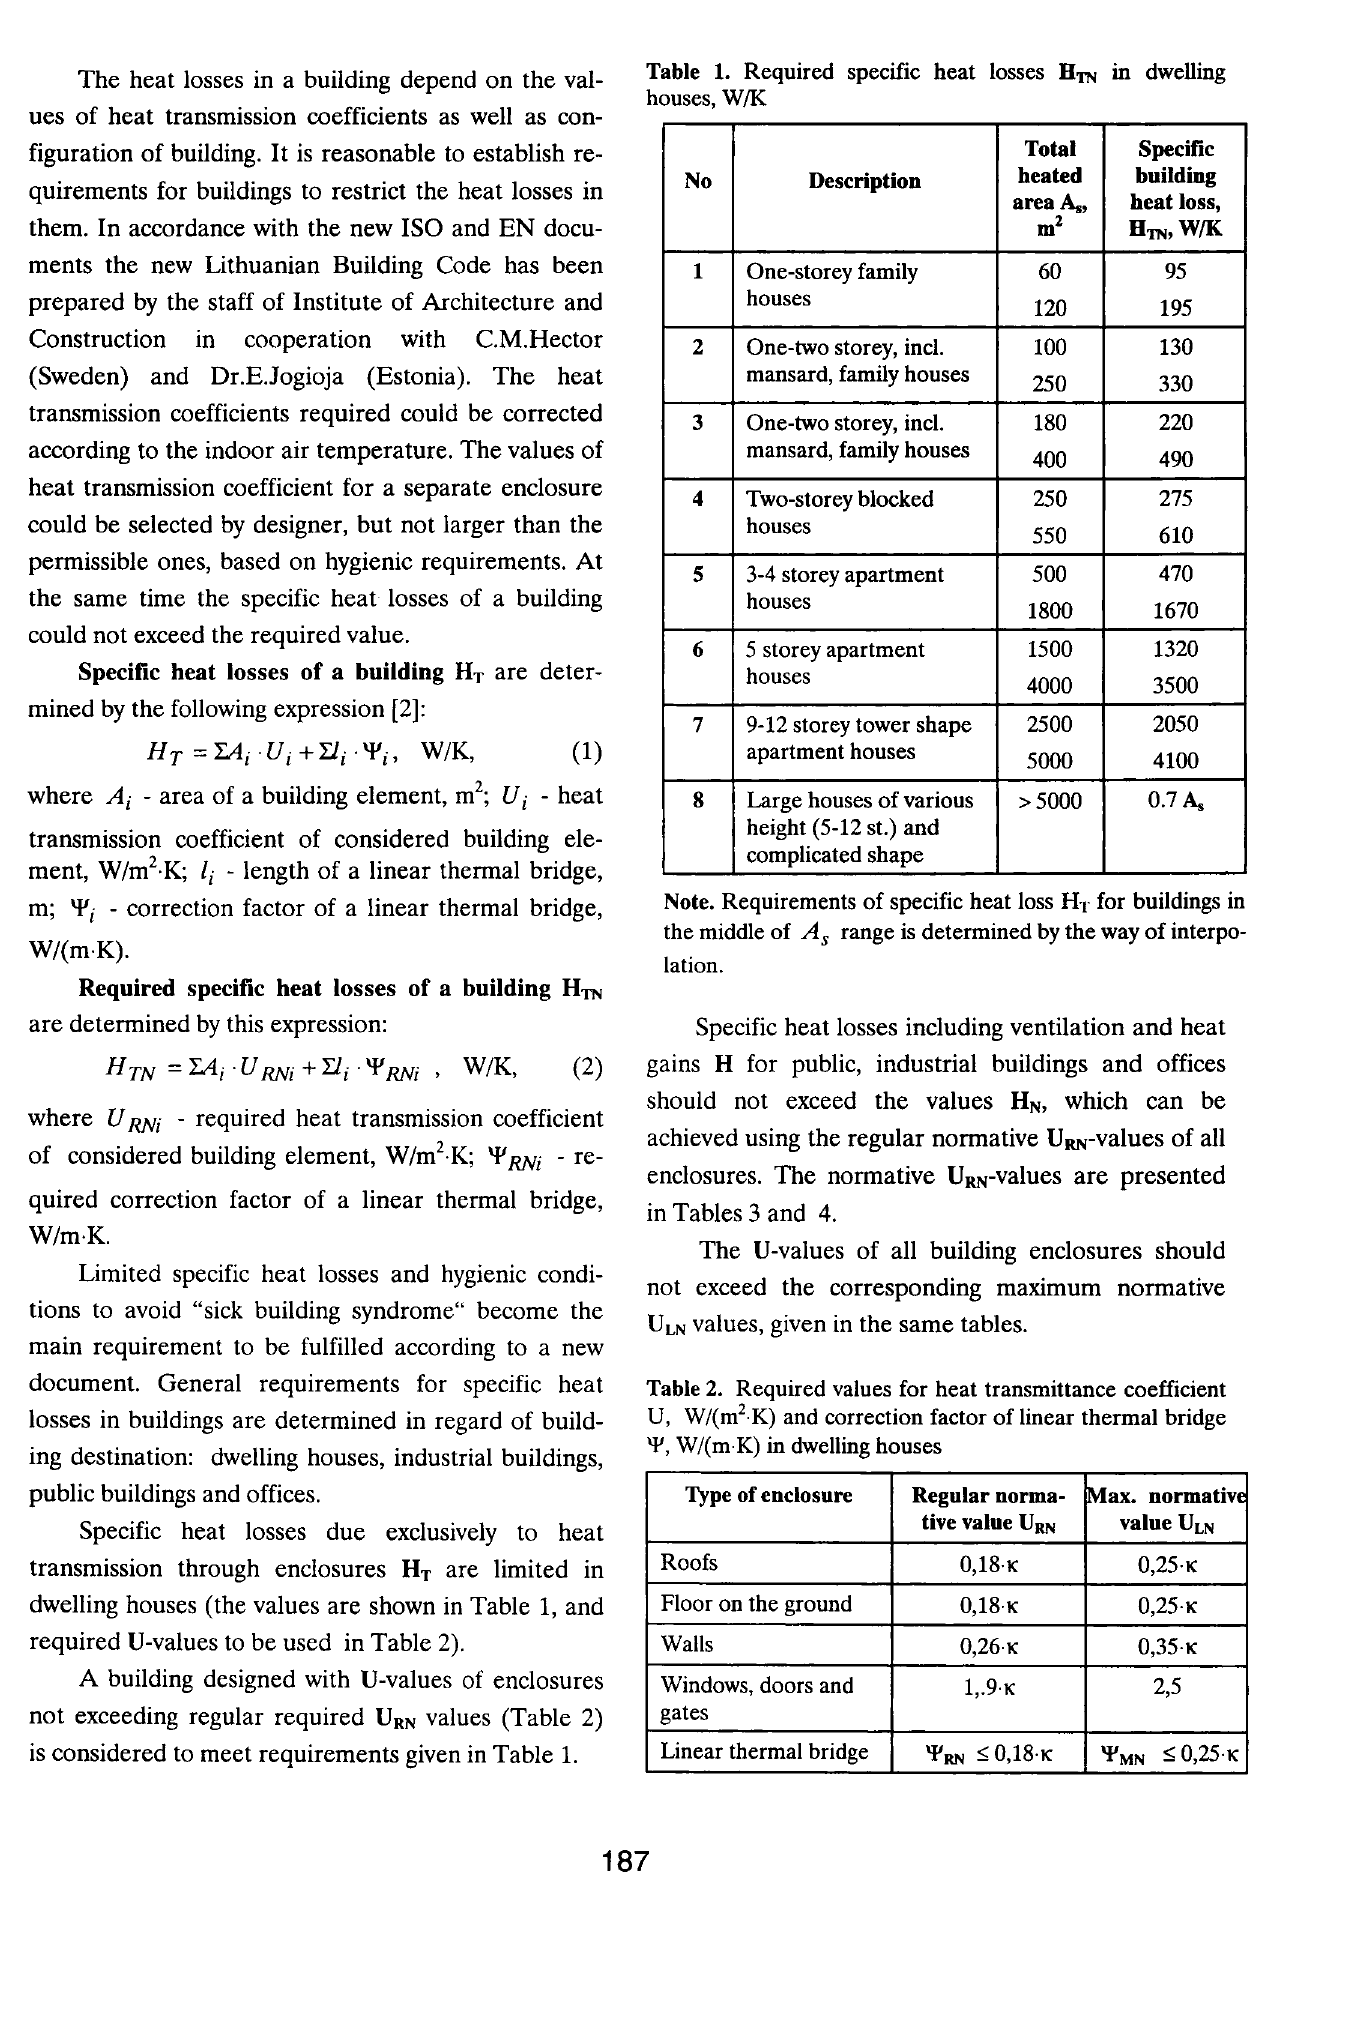
Table 2. Required values for heat transmittance